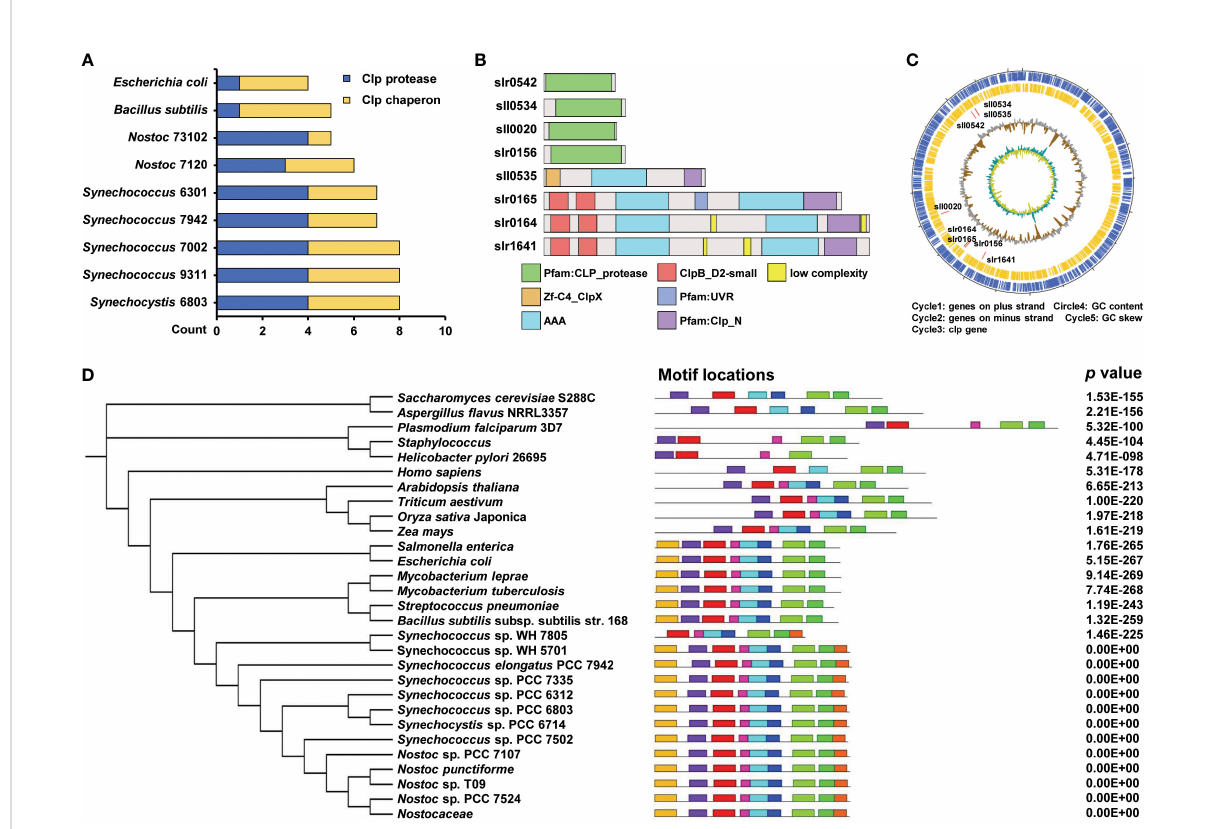
FIGURE 1 Conservativeness analysis of Clp family. (A) Comparing the number of Synechocystis sp. PCC 6803 Clp protease family homologs in different species. The blue and yellow columns indicate the count of Clp protease and Clp chaperon, respectively. (B) Schematic diagram of protein domains of Clp protease family from Synechocystis sp. PCC 6803. (C) The circos diagram indicates the whole Synechocystis sp. PCC 6803 genome. The outermost layer and inner layer denote the genes on the plus strand and minus strand in the genome, respectively. The third, fourth, and innermost layers denote the genomic position of the 8 Clp protease family members, % GC content, and GC skew, respectively. (D) Phylogenetic tree and motifs of ClpX protein. The tree was generated using a neighbor-joining algorithm. The conserved motif was analyzed using the MEME tool and nine different motifs were identi fi ed. Different motifs are denoted by different borders and colors, and the same color in different ClpX proteins refers to the same motif. Their combined p values are on the right side of the fi